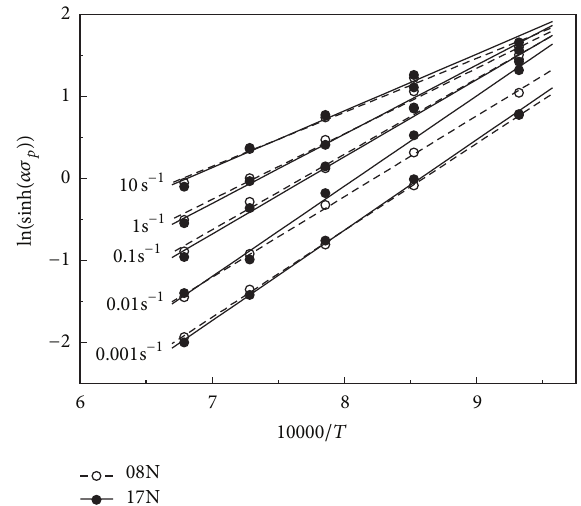
Figure 2: Strain rate sensitivity of 08N and 17N.